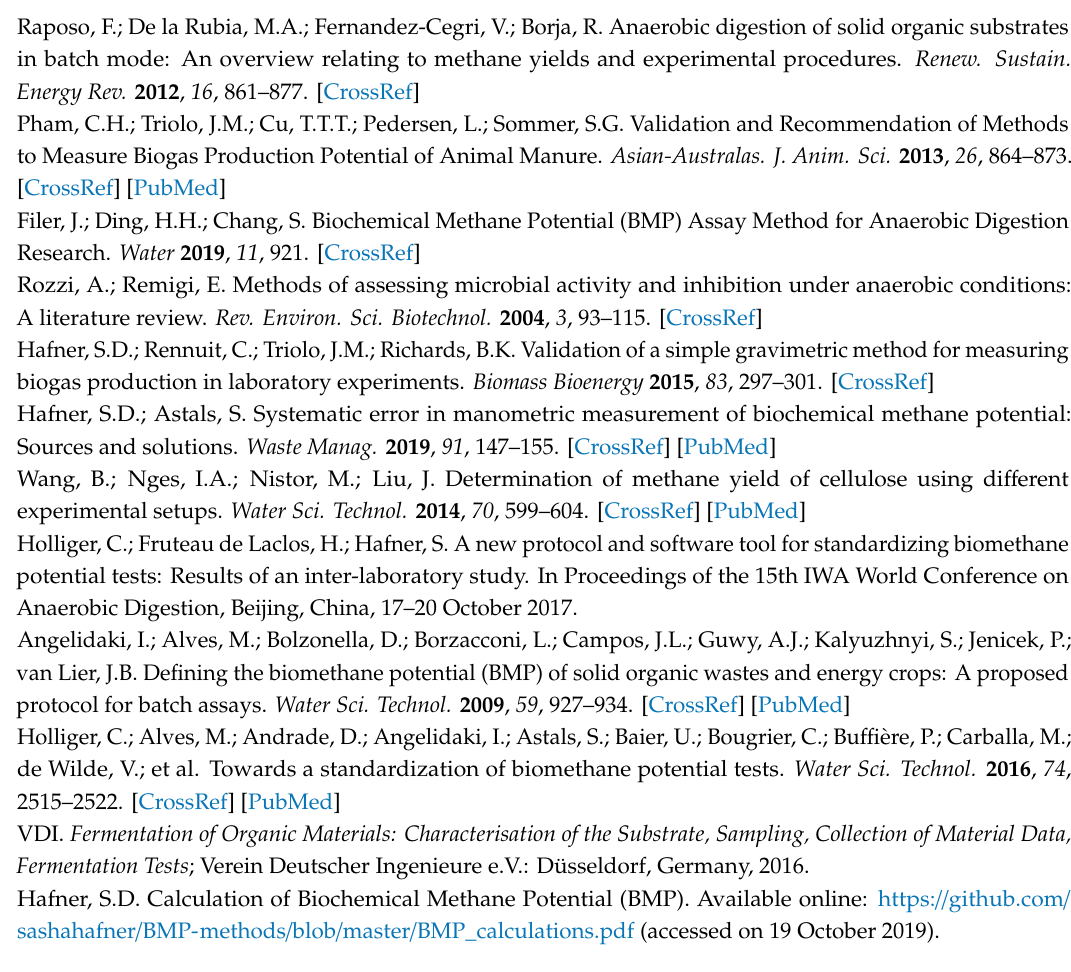
Table S1: Summary of the 8 GD-BMP algorithms. Table S2: Summary of substrates used for evaluation of the GD-BMP method. Table S3: First-order degradation rate constants for all SMP